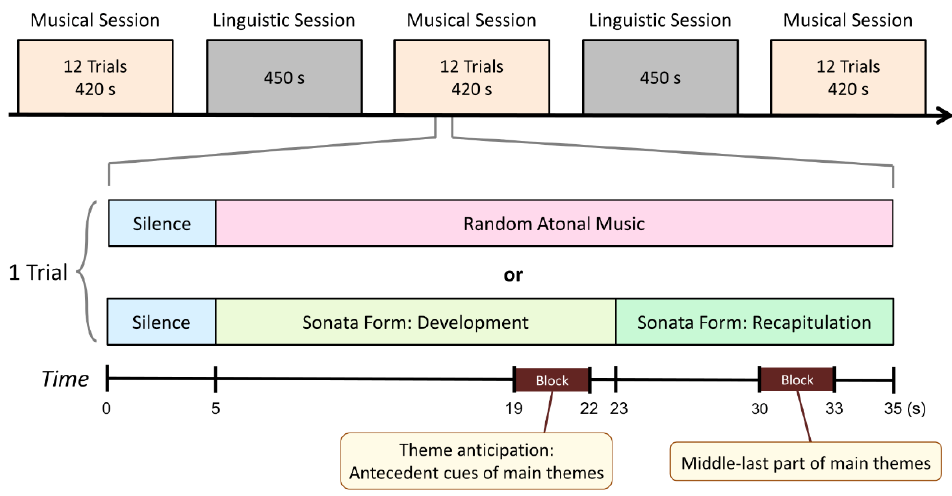
Figure 1. Schematic description of the functional scanning